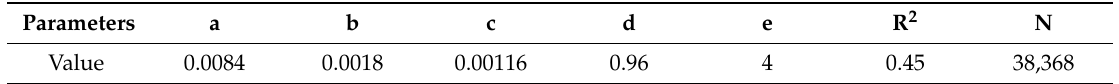
Table A1. Parameters in Equation (A1) obtained by the software Origin